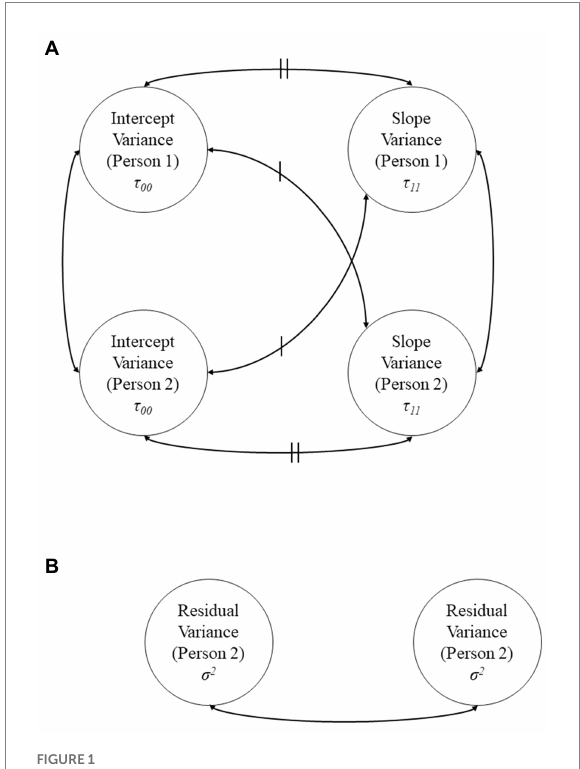
FIGURE 1 Conceptual diagram showing all modeled random effects and their covariances ( A ) and residuals and the within-dyad residual covariance ( B ). Intercept and slope variances are restricted equal within dyads (i.e., τ 00 = τ 00 and τ 11 = τ 11 ), as are residuals (i.e., σ 2 = σ 2 ). Curved double-headed arrows represent covariances, and hashmarks denote covariances that have been restricted